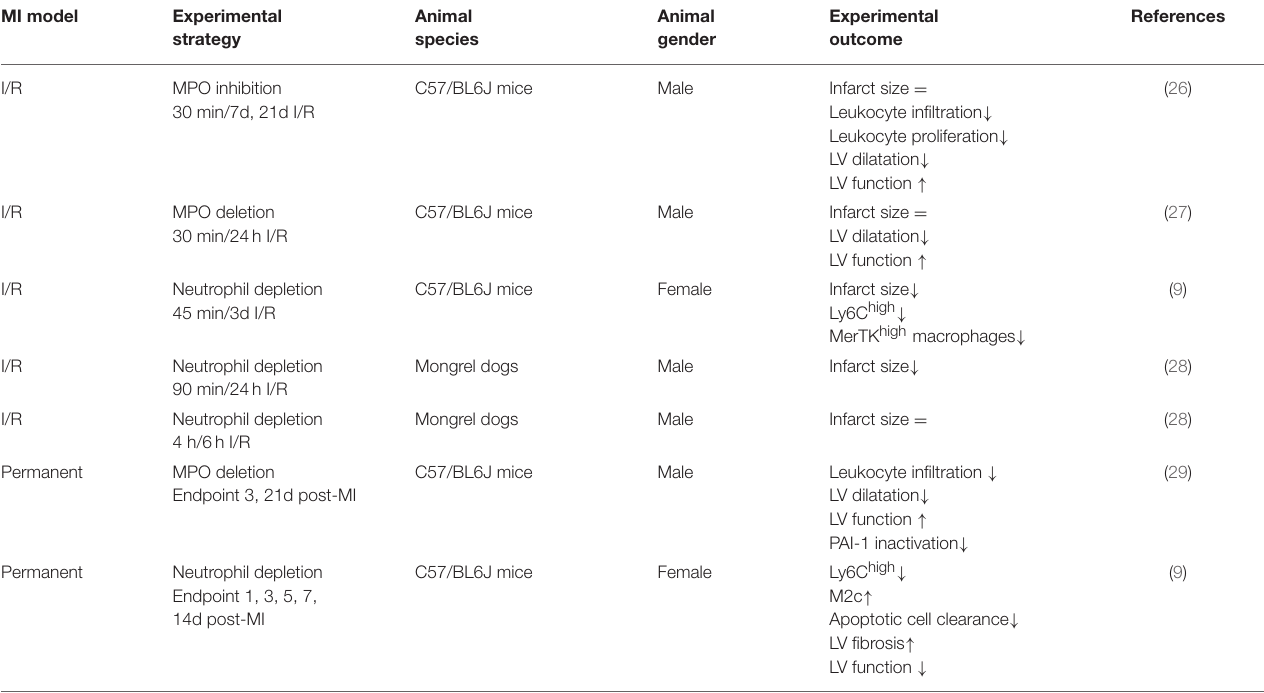
TABLE 1 | Experimental studies targeting neutrophil counts or function in post MI healing and remodeling. MI